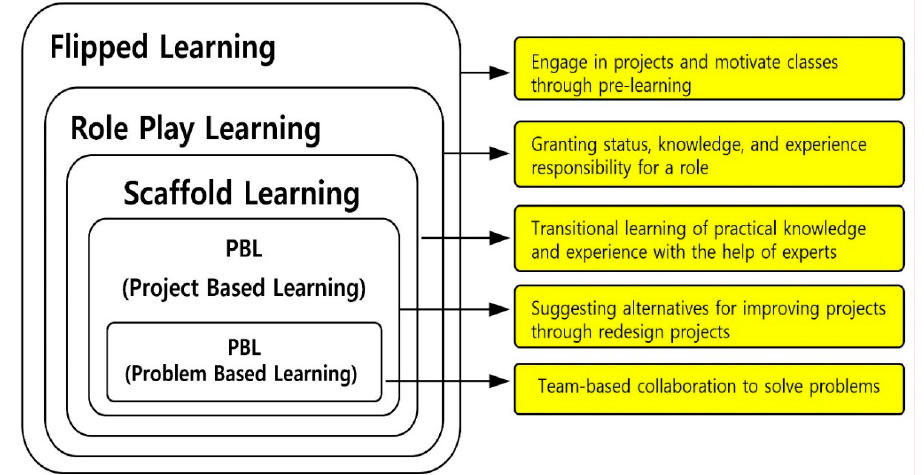
Figure 1. Social Constructivism Theories’ composition and advantages.